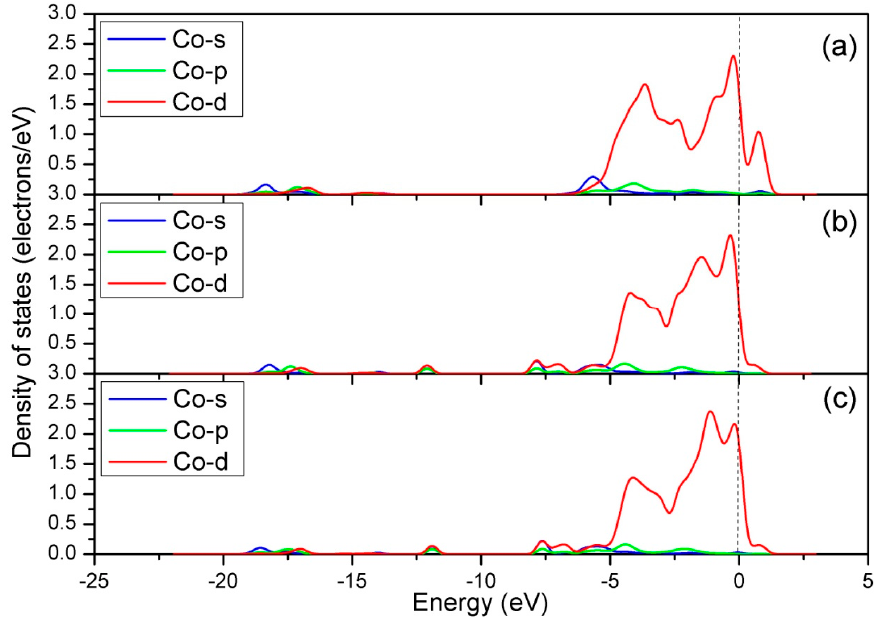
Figure 7. Density of states of the adsorbed Co site: ( a ) Before NO adsorption for the perfect CoO 2 -terminated LaCoO 3 (011) surface, ( b ) after NO adsorption for the perfect CoO 2 -terminated LaCoO 3 (011) surface, and ( c ) after NO adsorption for the Ce-doped CoO 2 -terminated LaCoO 3 (011) surface.